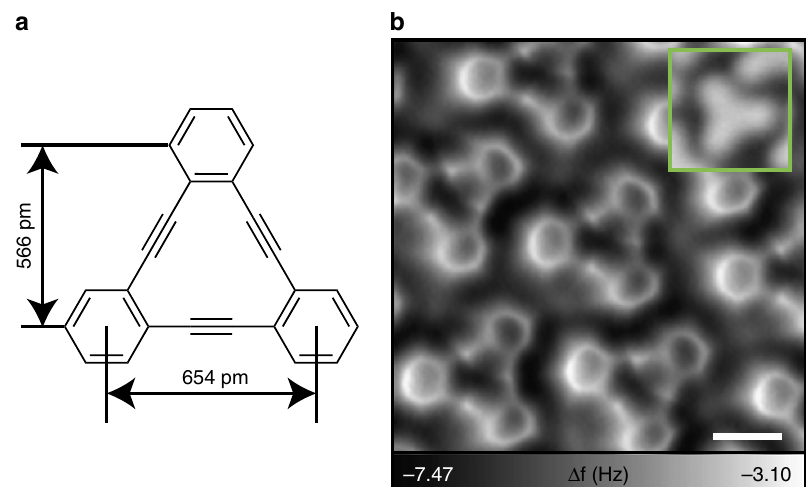
Figure 1 | Intact tDBA on Ag(111). ( a ) Chemical structure of triangular dehydrobenzo[12]annulene (tDBA). ( b ) High-resolution AFM image of tDBA on Ag(111). Inset shows the STM topography. Measurement parameters: V tip ¼ 0mV and A ¼ 60pm in b and V tip ¼ (cid:2) 200mV and I ¼ 1pA in (inset). Scale bar, 500pm.